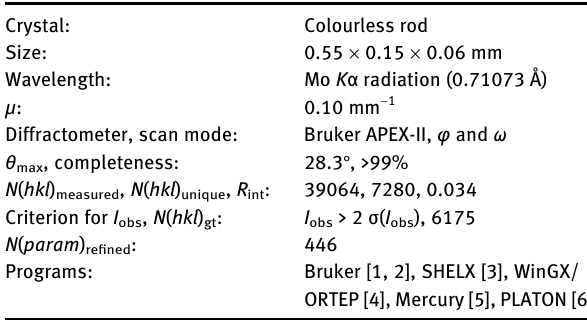
Approximately 0.1 mol o-phenylene diamine and 0.1 mol tartaric acid were re fl uxed in 100 mL 4 M HCl in a round bottomed fl ask for 1 h. The fl ask was allowed to cool to room temperature and then the purple solution was neutralized with conc. NH solution. The brown precipi- 3 tate was fi ltered off and recrystallised from a mixture of water and ethanol. Brown crystals were formed.